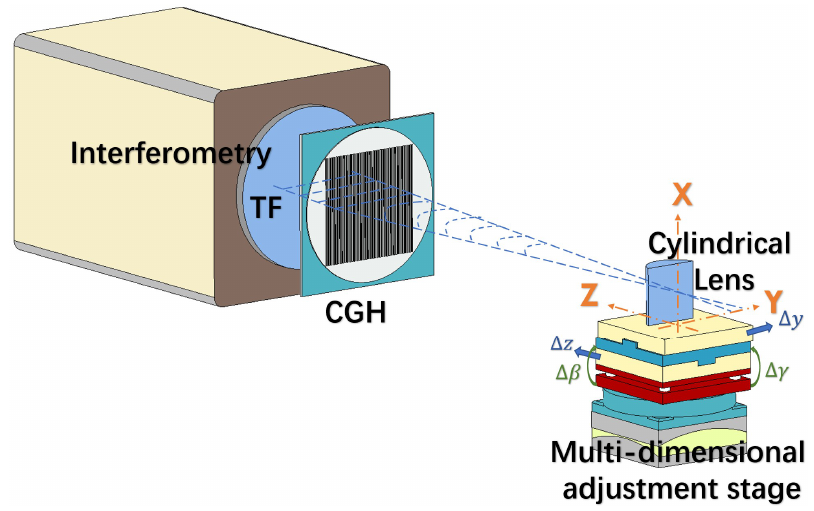
Figure 1. Schematic view of the cylindrical interference system.